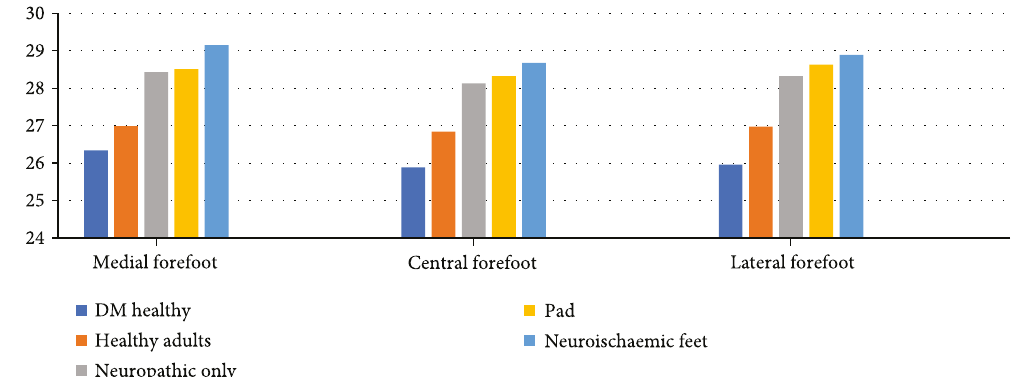
Figure 3: Forefoot temperature